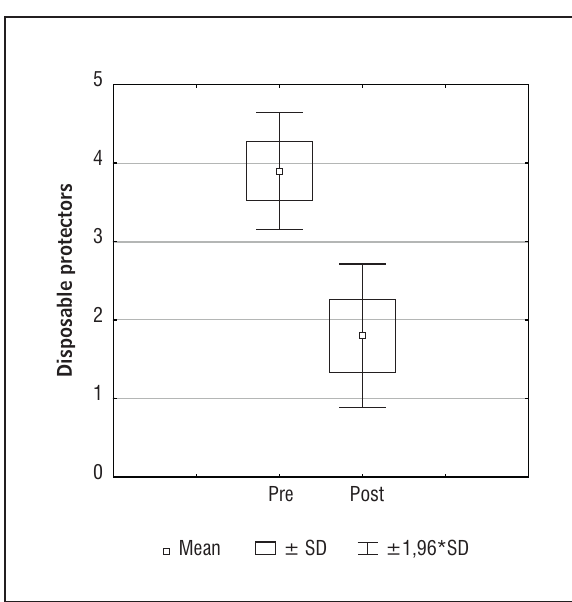
Figure 3 - Amount of disposable protectors used before and after 16 sessions of endoanal electrostimulation (Student’s paired t-test, 5.16; P =